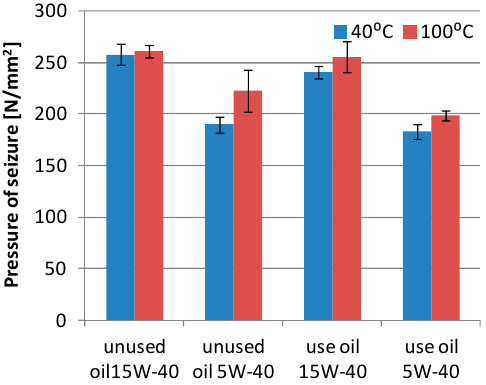
Figure 9. Pressure of seizure of the unused and used oil; 15W-40 and 5W-40.